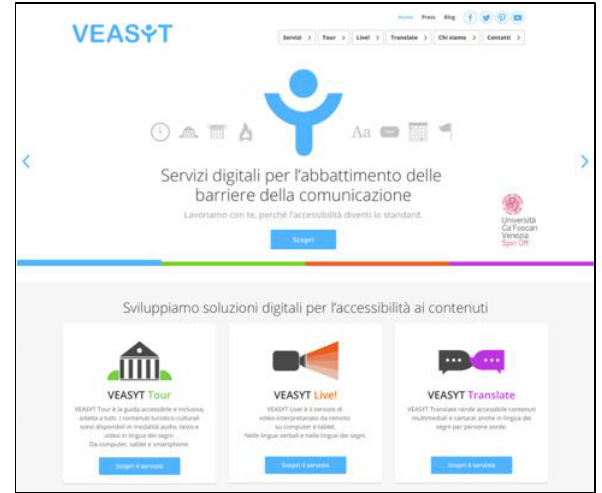
Figure 1. Screenshot of VEASYT Website. Source: http://www.veasyt.com